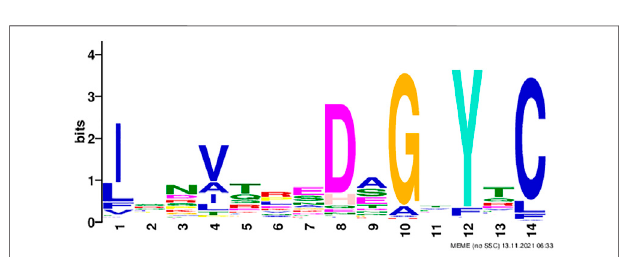
FIGURE 4 | Motif discovered among immunoglobulin sequences using the MEME tool; the height of the letter indicates its relative frequency at the given position within the